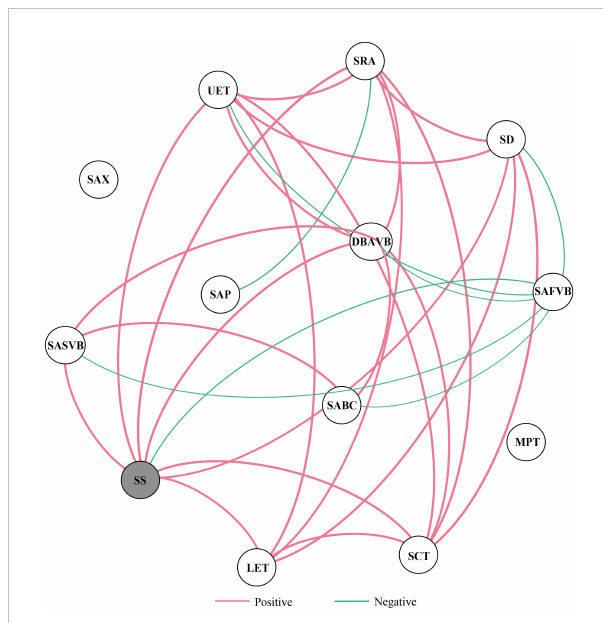
FIGURE 5 Trait correlation network of stomatal and anatomical traits of moso bamboo. Note: The red and green edges indicate positive and negative correlations, respectively. The thickness of the edges indicates the strength of the correlation. Traits marked by gray circles show the high centrality values in terms of degree and weighted degree.